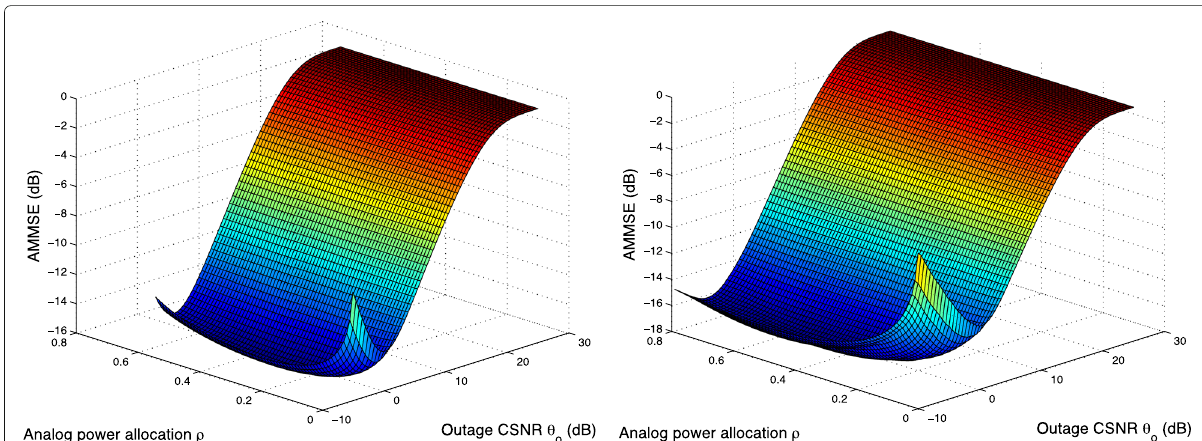
Fig. 2 AMMSE of HDA-PQ ( left ) and HDA-TC ( right ) for a Gauss-Markov source with a = 0.9, as a function of the analog power allocation ρ and the outage CSNR θ o . Mean CSNR of the channel is 15 dB, and the bandwidth expansion factor is b = 4. HDA-PQ prediction order is 1, and HDA-TQ transform block size is